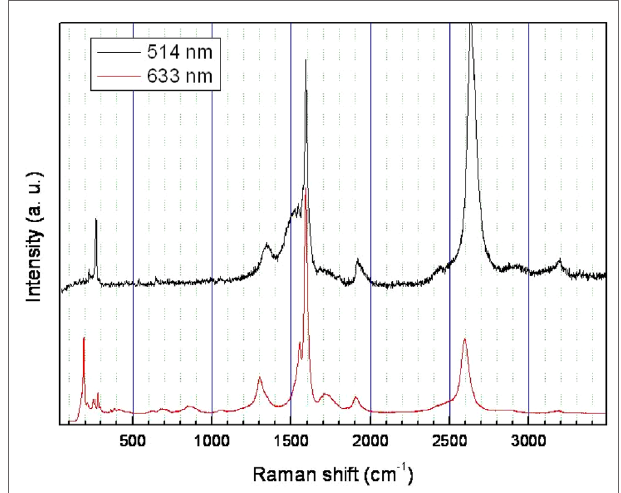
FigUre 3 | laser raman spectroscopic measurements of the as-prepared sWcnTs produced at 820°c . The wavelengths of the incident lasers are 514 and 633 nm,